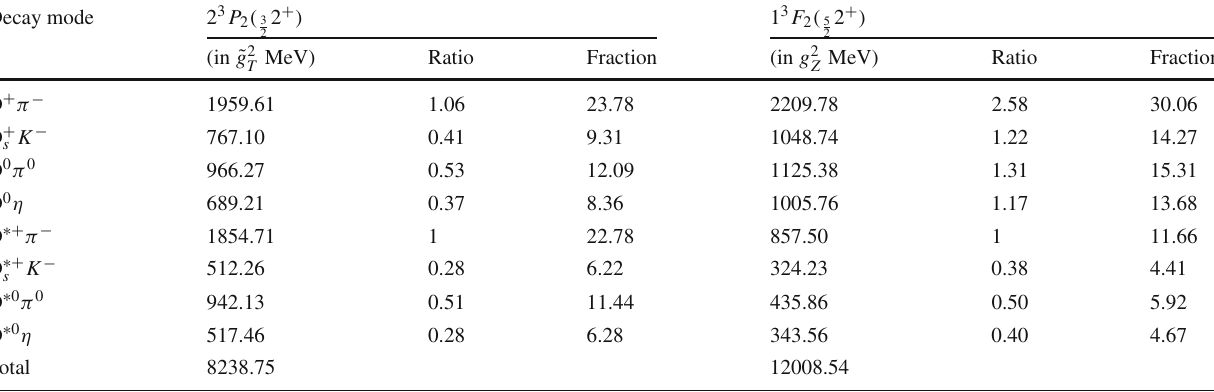
Table 12 The strong decay widths (in MeV) for resonance D ∗ (cid:21) (cid:21)( D ∗ → D ∗+ π − ) . Fraction (in%) represents the percentage of the partial decay width with respect to total decay width J Decay mode